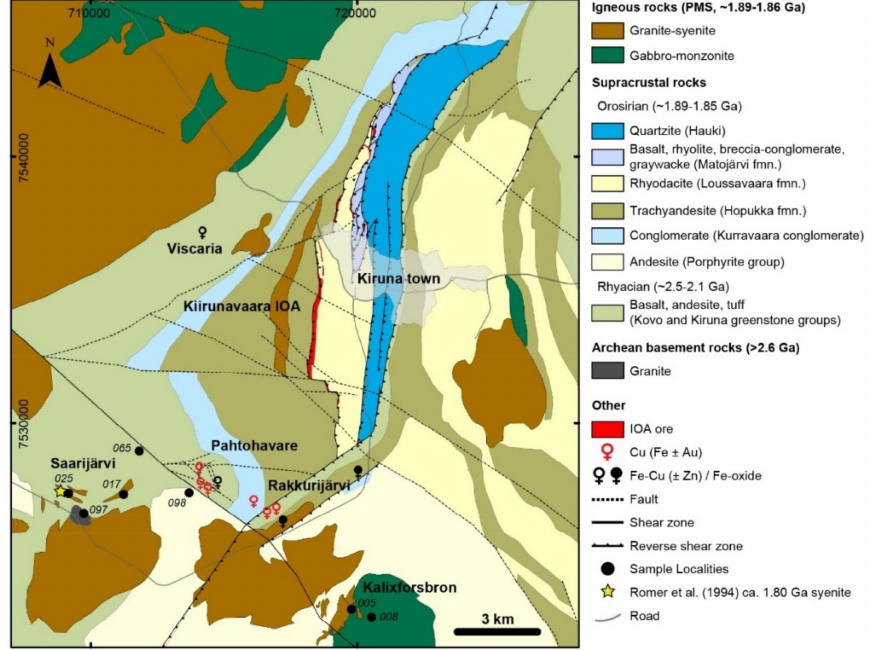
Figure 2. Geologic map of the Kiruna mining district showing stratigraphy, structures, and igneous intrusions. Kiruna town is marked in gray. Sampling locations and the local names of the areas are indicated. Modified after Martinsson et al. [62] and Andersson et al. [21]. Coordinate system in